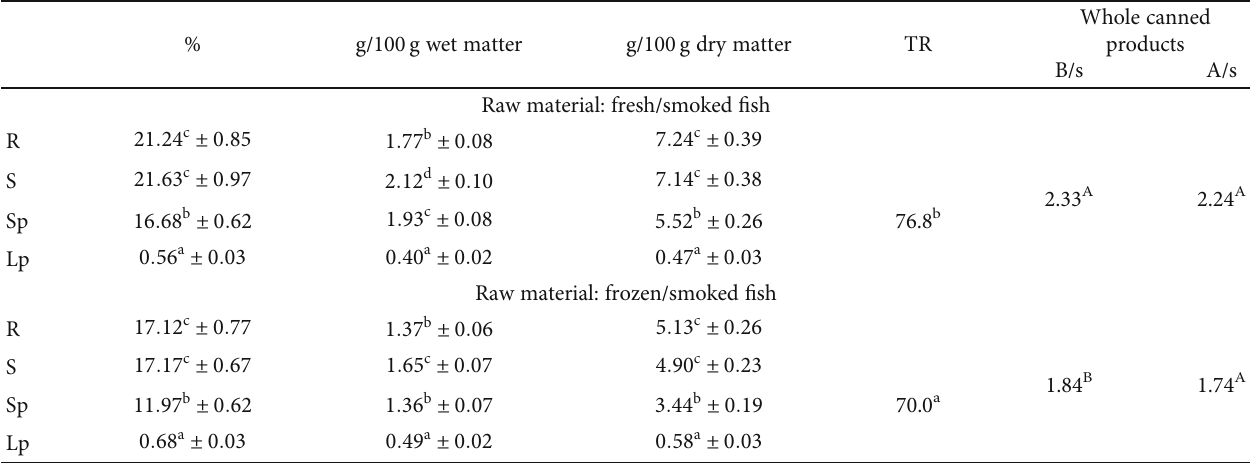
Table 4: Contents of the sum of EPA and DHA, TR in raw fi sh, smoked fi sh, and solid and liquid parts of canned fi sh and whole canned